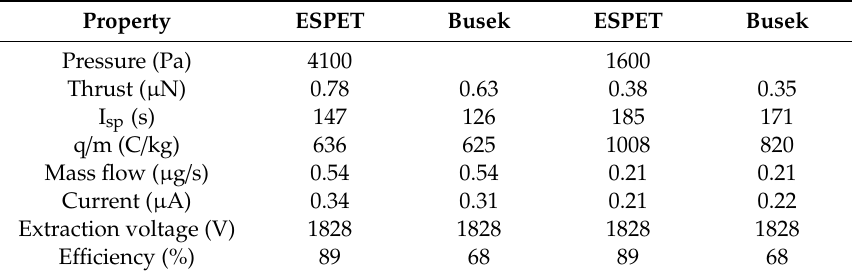
Table 5. Comparison between ESPET predictions and Busek measurements for an EMI-TFSI propelled single capillary thruster. ESPET pressure is set to generate Busek mass